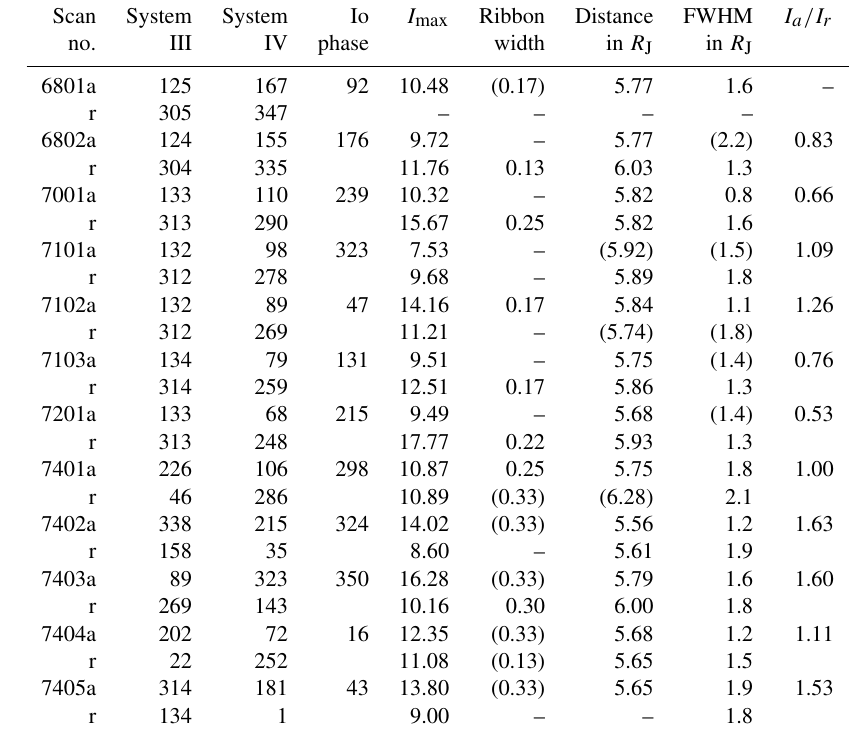
Table 1. The Voyager 1 outbound data results in table form. For each scan of the torus the relevant information is given for the approaching (a) and receding (r) ansae. The values between brackets indicate poorly determined fits of the brightness. Whenever there is a dash in the ribbon width column, the data could not be fitted with a ribbon-included model. For scan 6801r there was a significant data gap, so no brightness